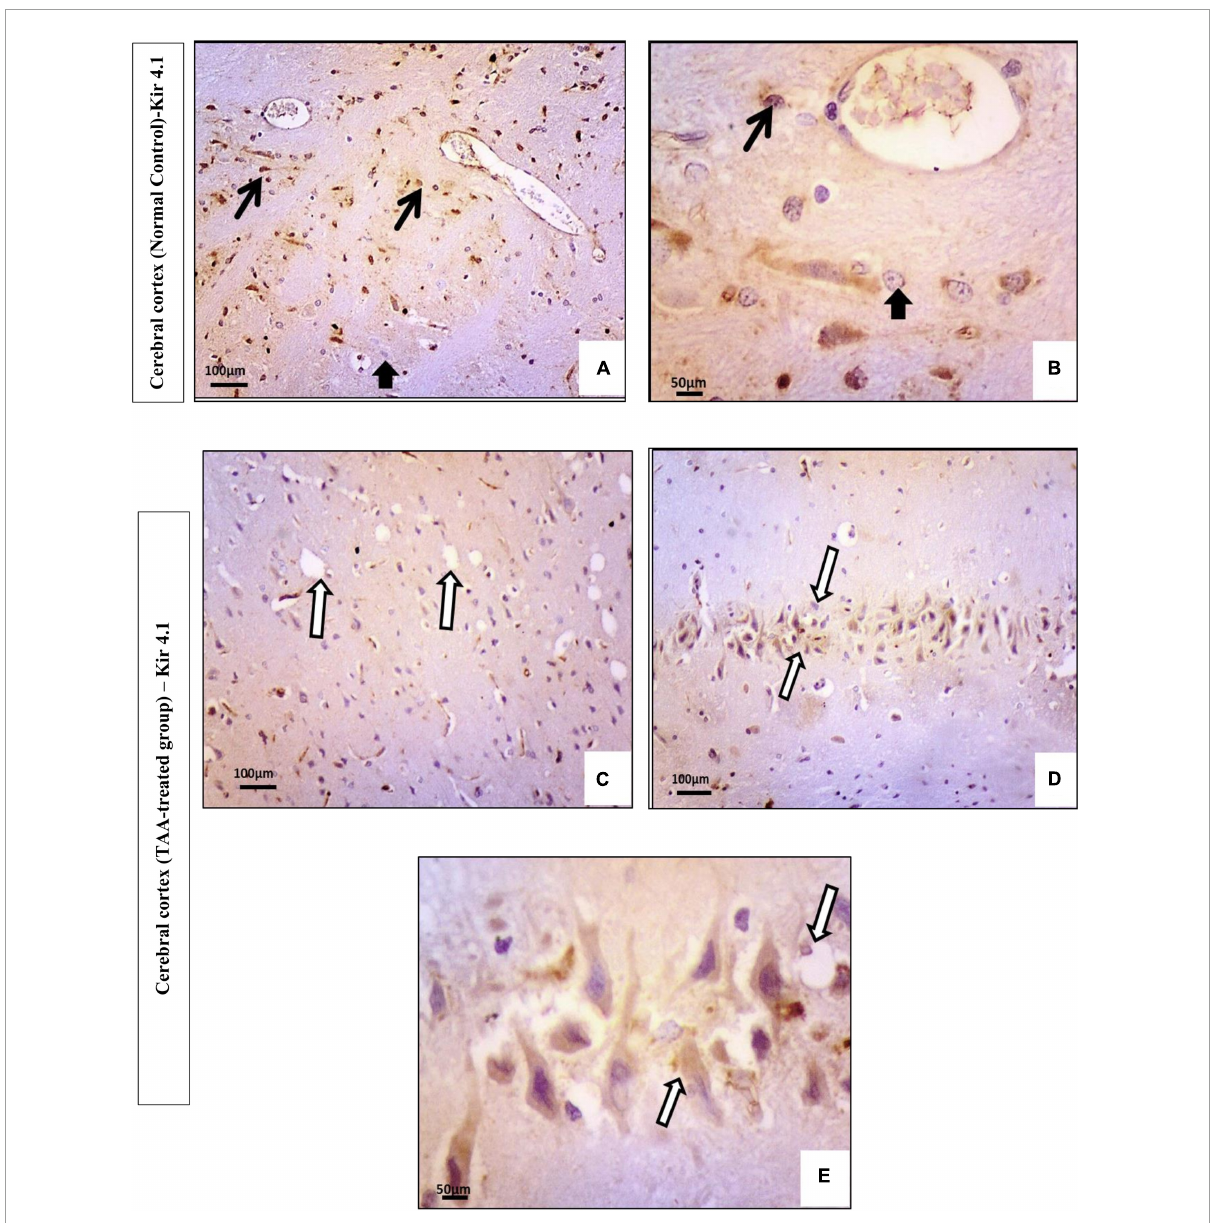
FIGURE10 (A–E) Microscopic pictures of immunostained cerebral cortical sections against Kir4.1 of control and treated groups. (A,B) Control group showing expression in astrocytes near the blood vessels (black arrows) and negative expression in neurons (short arrow). (C–E) Cerebral cortical sections from the TAA-treated group. (C) Micrograph showing vacuolation and pyknotic nuclei of astrocytes with decreased expression (white arrows). (D,E) Hypertrophied astrocytes with moderated expression (arrowhead). X: 400 bar 50 and X: 200 bar